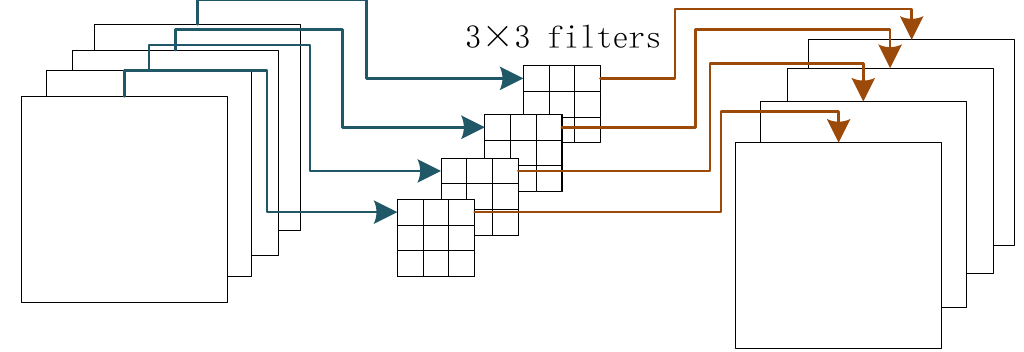
Figure 2. The illusion of the depth-wise